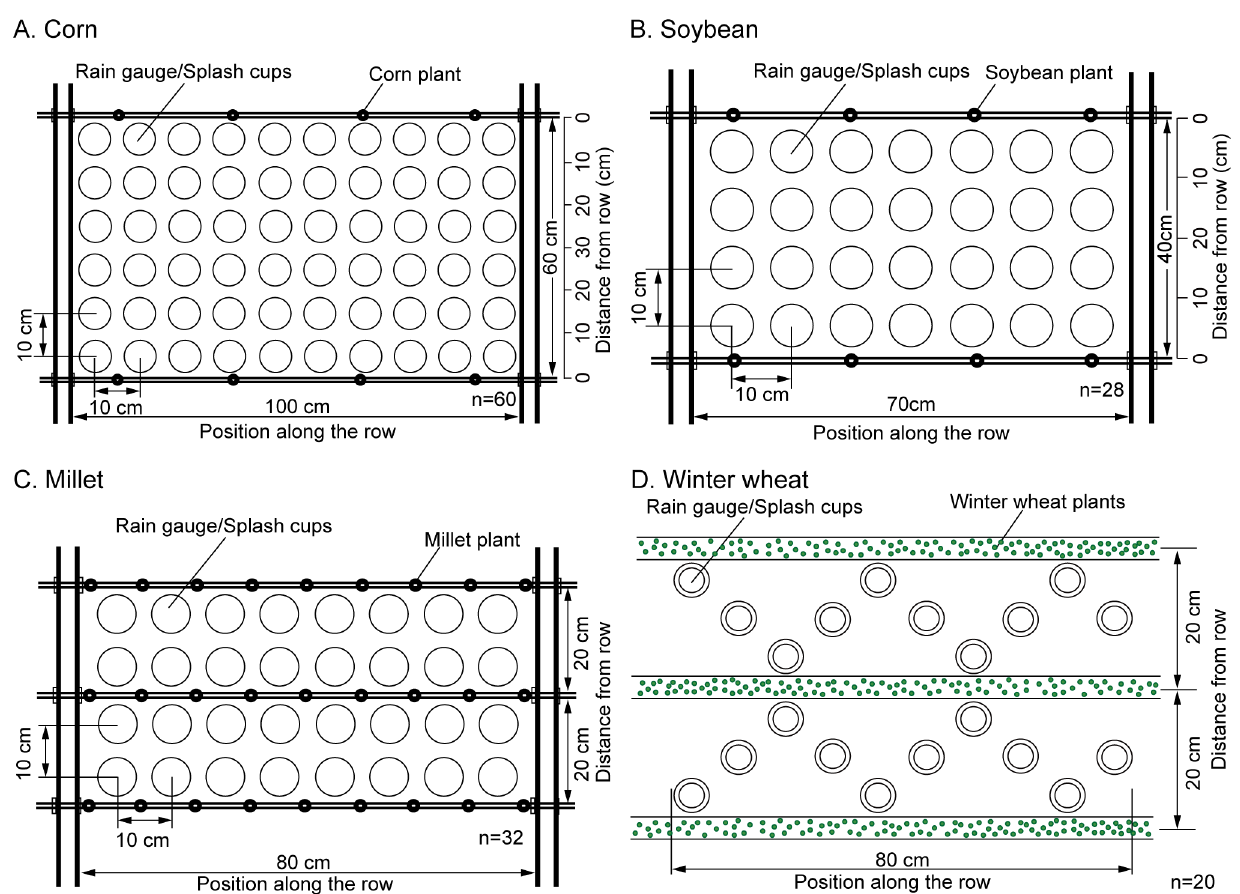
Figure 1. Schematic diagram of measurement for throughfall and splash detachment under crop canopy. doi:10.1371/journal.pone.0099717.g001 PLOS ONE |